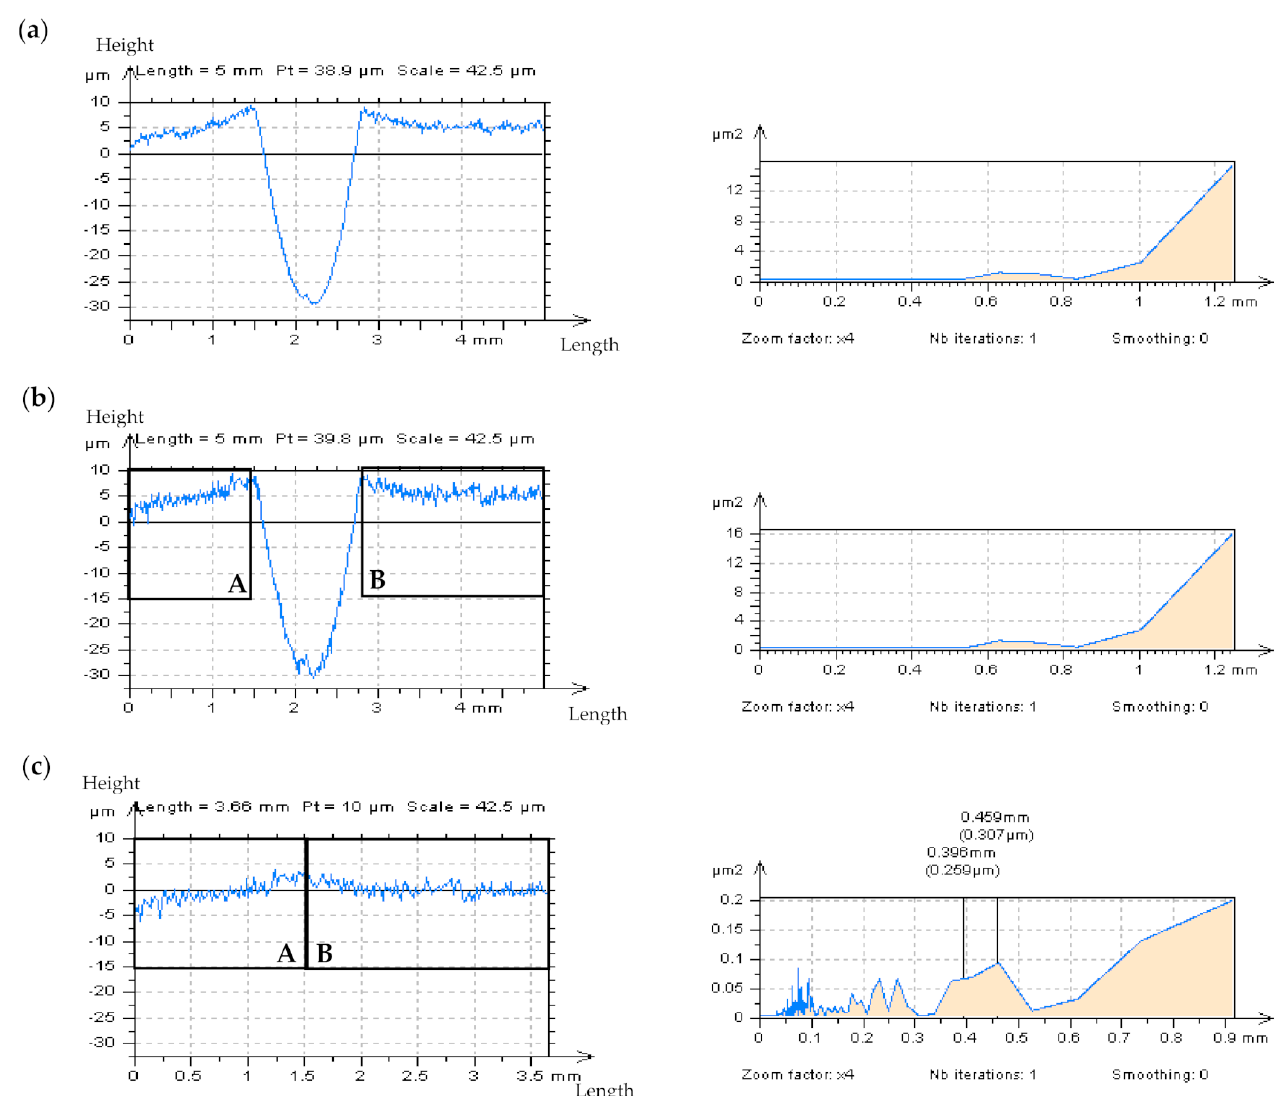
Figure 3. Profiles and their PSDs respectively decomposed from the plateau–honed cylinder liner surface texture containing deep/wide dimple with stylus measuring 0.5 mm/s ( a ) and with simulated high–frequency noise ( b ) with Sq equal to 20% of Sq of the assessed profile ( b ) and AB–profile ( c ) created using